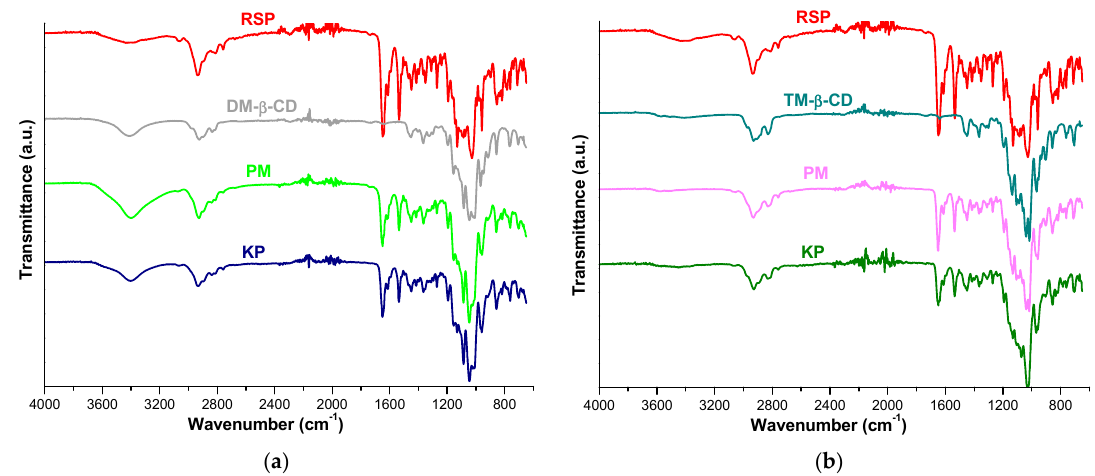
Figure 7. FTIR spectra of RSP, DM- β -CD and their corresponding products PM and KP ( a ); RSP, TM- β -CD and their PM and KP ( b ).